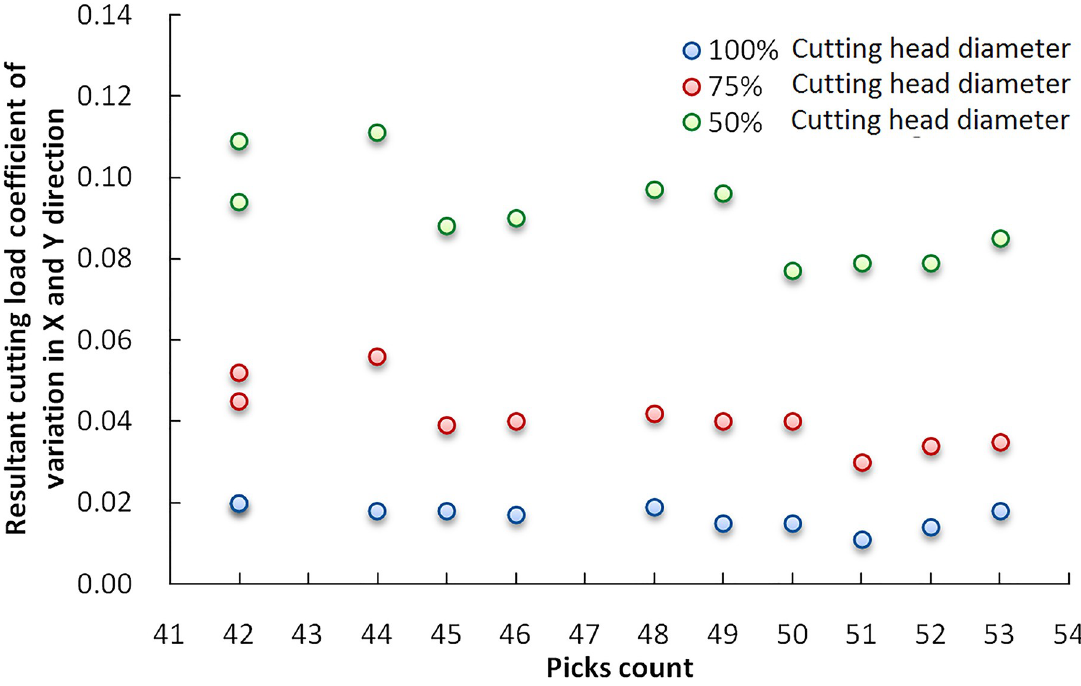
Fig 13. Cutting load CV and cutting